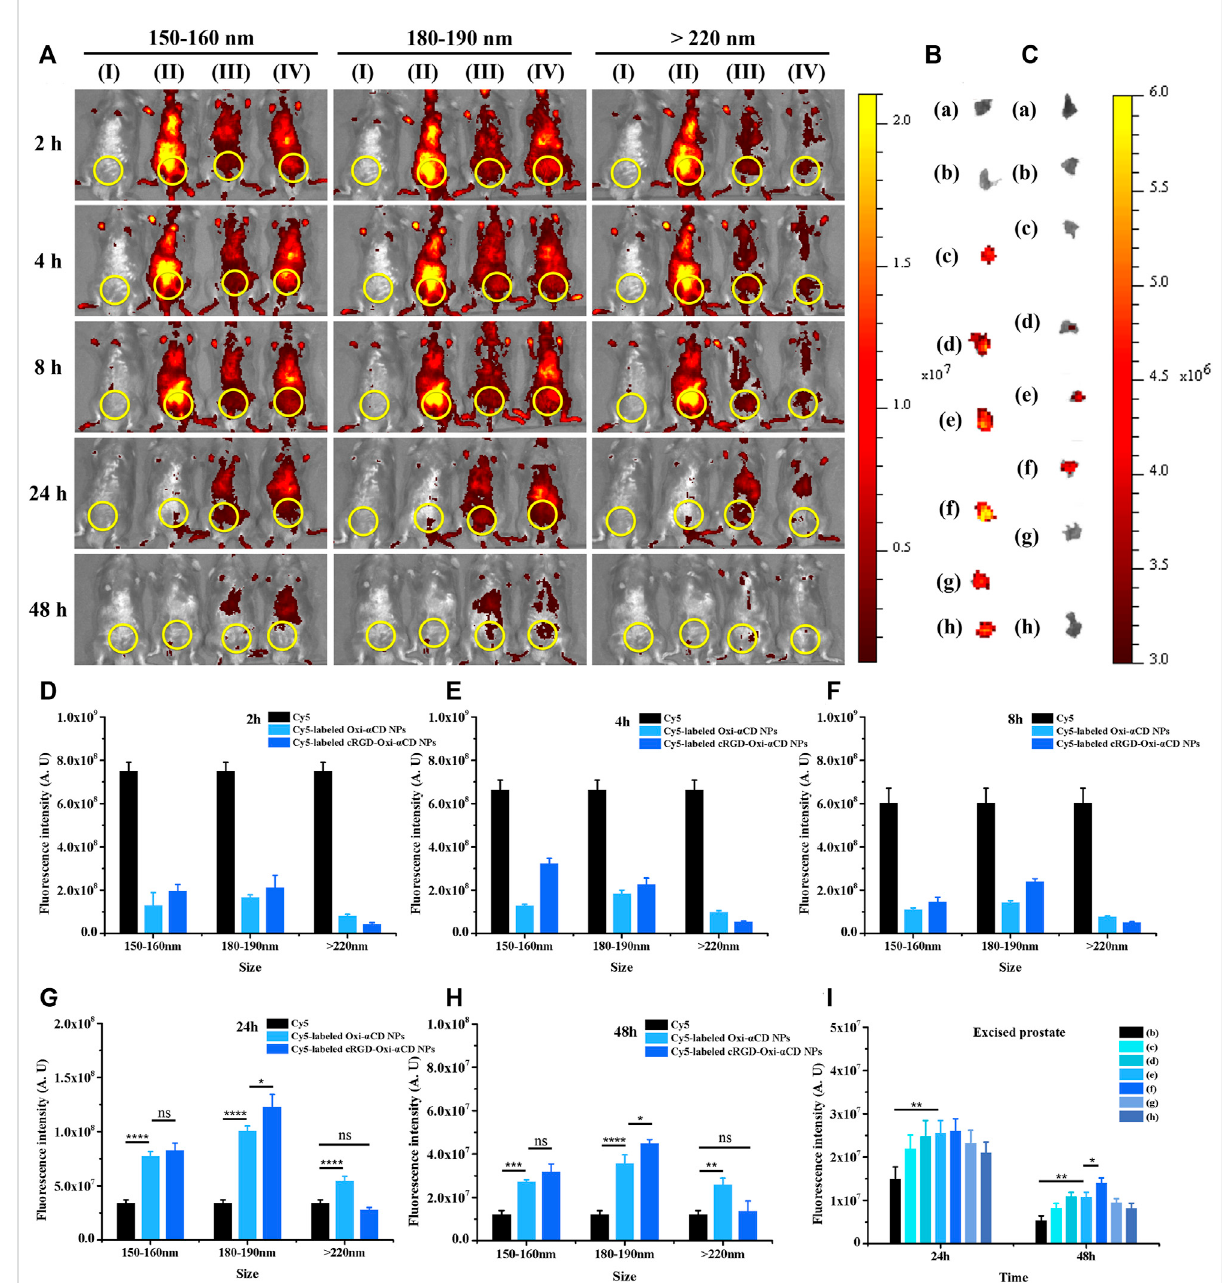
FIGURE 5 In vivo distribution of Cy5-labeled Oxi- α CD NPs and RGD-Oxi- α CD NPs in a murine model of CBP. (A) In vivo fl uorescence images of (I) saline, (II) free Cy5, (III) Cy5-labeled Oxi- α CD NPs and (IV) Cy5-labeled RGD-Oxi- α CD in a murine model of CBP at different time points after intravenous injection (the region in the yellow circle indicates the lower urinary tract and part of the reproductive system). (B – C) Ex vivo fl uorescence images of theexcisedprostates at24 h (B) and 48 h (C) postinjection: (a) saline, (b)freeCy5, (c) Cy5-labeled Oxi- α CD NPs (150 – 160 nm), (d) Cy5-labeled cRGD-Oxi- α CD NPs (150-160 nm), (e) Cy5-labeled Oxi- α CD NPs (180-190 nm), (f) Cy5-labeled cRGD-Oxi- α CD NPs (180-190 nm), (g) Cy5-labeled Oxi- α CD NPs ( > 220 nm) and (h) Cy5-labeled cRGD-Oxi- α CD NPs ( > 220 nm). (D – H) ROI analysis of fl uorescence intensity in the lower urinary tract and part of the reproductive system was performed at different time points after intravenous injection ( n = 3 per group). (I) ROI analysis of the fl uorescence intensity of the excised prostate at 24 h and 48 h *, signi fi cantly different at p < 0.05; **, signi fi cantly different at p < 0.01; ***, signi fi cantly different at p < 0.001; ****, signi fi cantly different at p <